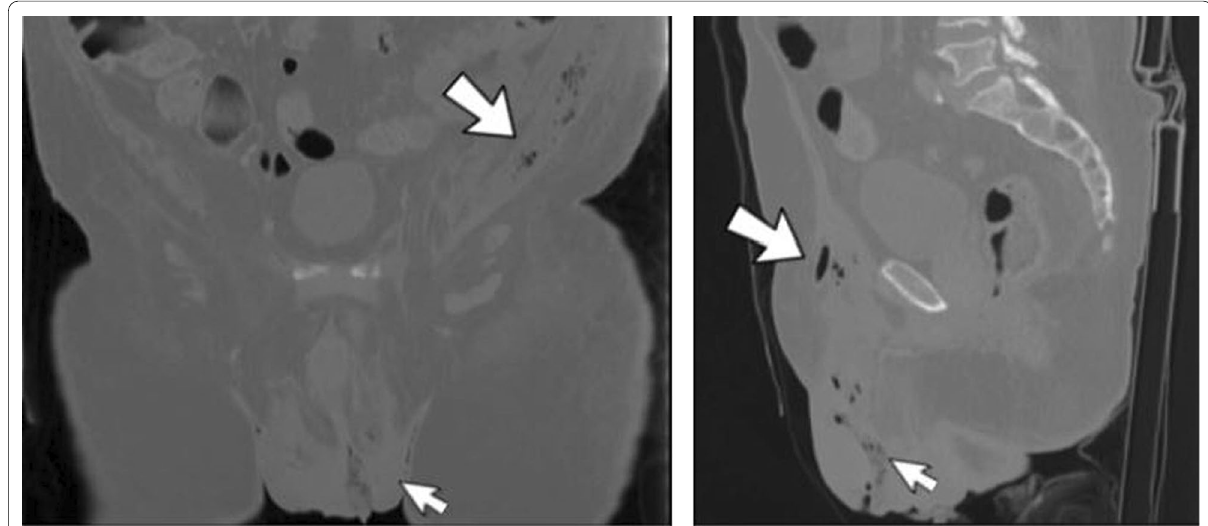
Fig. 4 Coronal plane (left) and sagittal plane (right) CTAP without contrast showing development of a large anterior abdominal wall abscess measuring 26-cm 4-cm (thick arrows) extending into the scrotum (thin arrows) ×